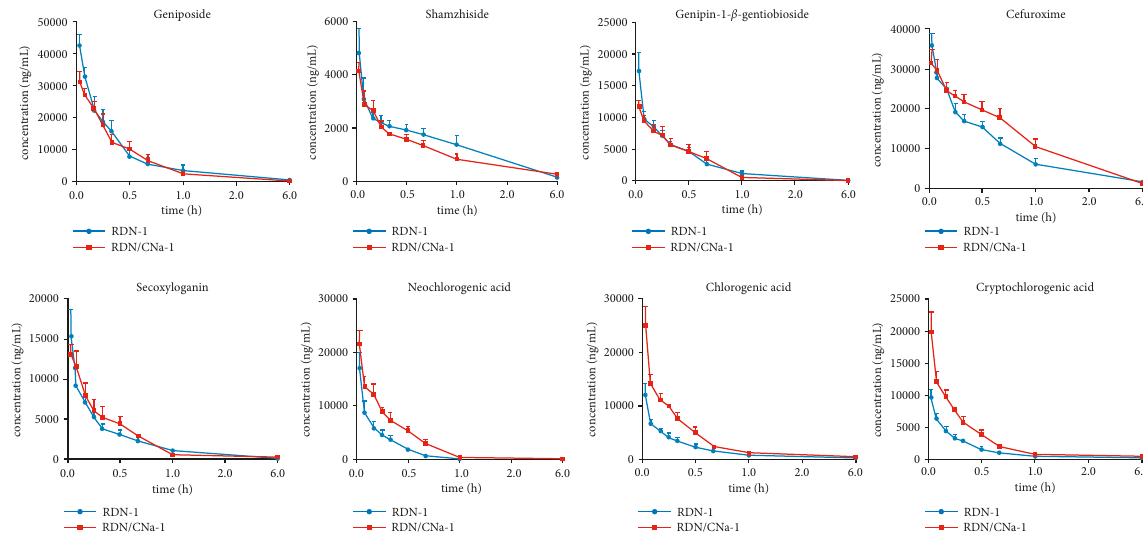
Figure 4: The mean plasma concentration-time profiles of seven analytes with cefuroxime after single coadministration of RDN and CNa.